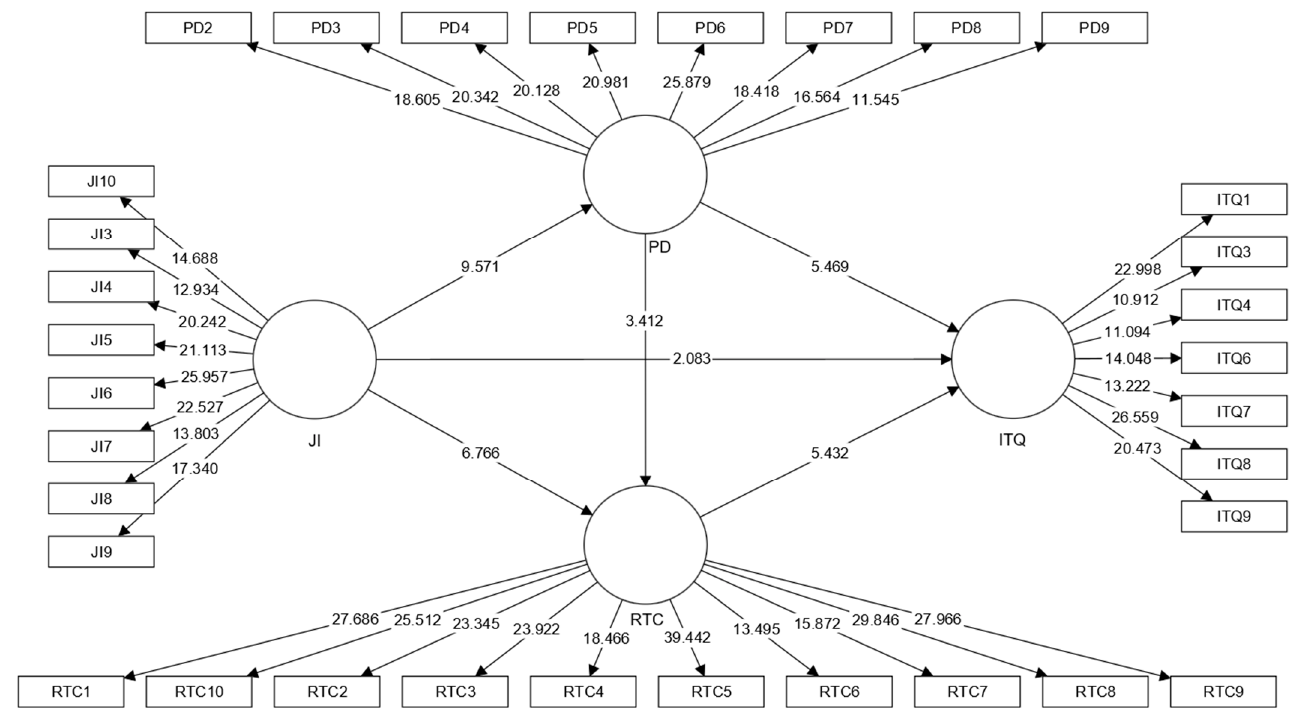
Figure 3. Structural